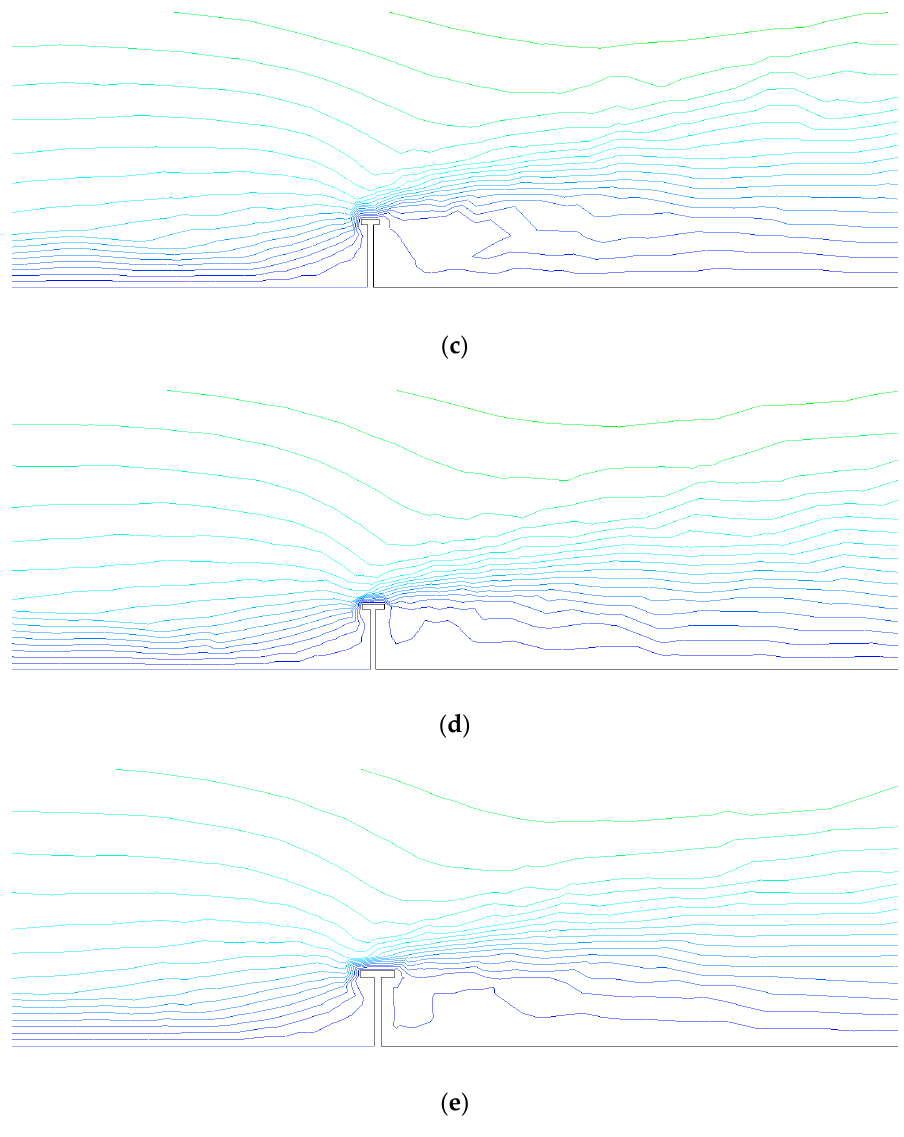
Figure 16. Velocity streamline on symmetry plane. ( a ) Base case; ( b ) case 1; ( c ) case 2; ( d ) case 3; ( e ) case 4.